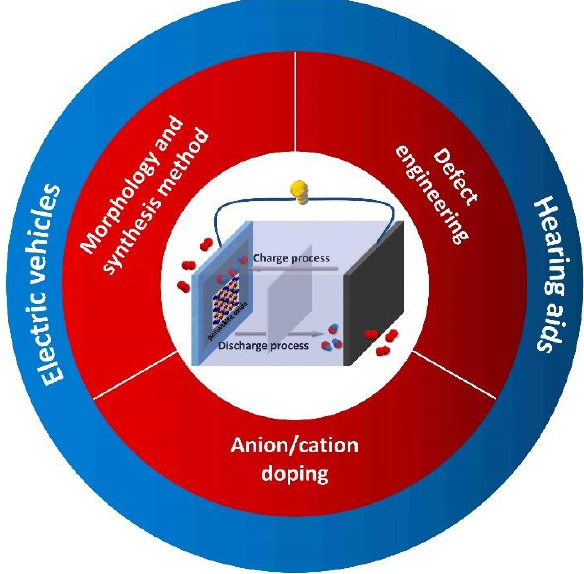
Figure 1. Modulation strategies of perovskite oxide for applications in zinc-air batteries.